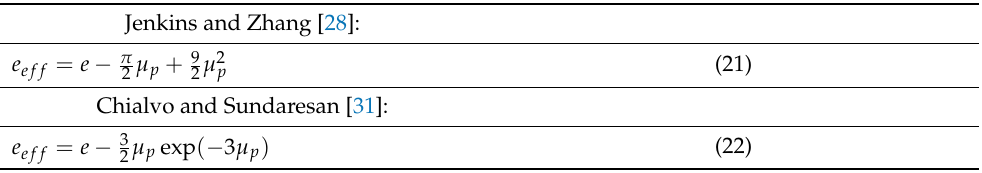
Table 6. Effective restitution coefficient accounting for particle